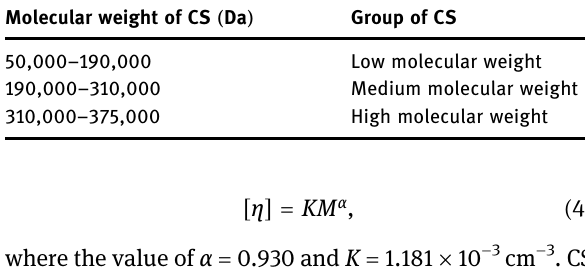
Table 4: CS grouping based on molecular weight Molecular weight of CS ( Da )